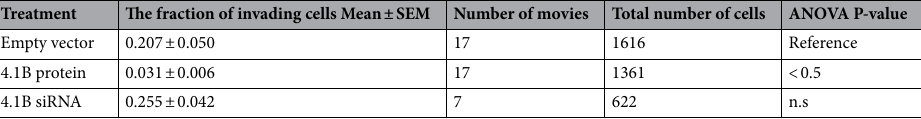
Table 1. Results of the assay with A549 cells invading monolayers of pneumocytes type II. Protein 4.1B significantly suppressed the invasion. Downregulation of 4.1B achieved a numerically higher mean value but without statistical